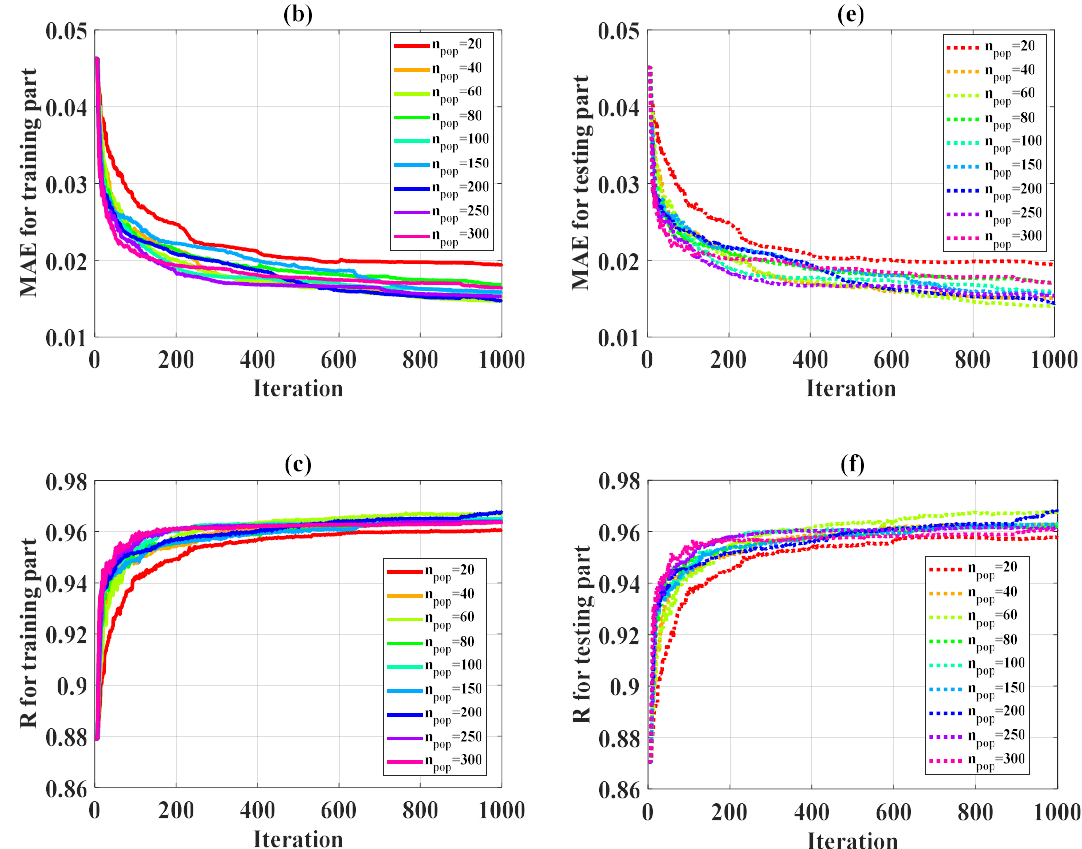
Figure 5. Convergence of several statistical criteria over 1000 iterations in terms of n pop for the training part: ( a ) RMSE, ( b ) MAE, ( c ) R. Convergence of several statistical criteria over 1000 iterations in terms of n pop for the testing part: ( d ) RMSE, ( e ) MAE, ( f ) R.